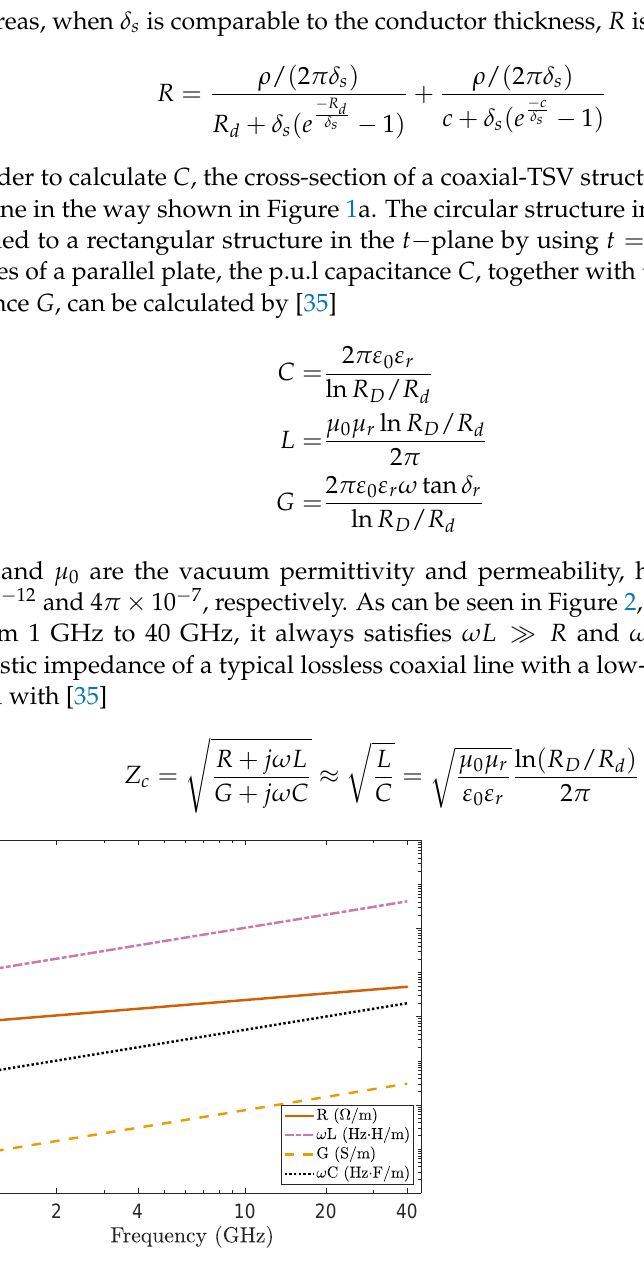
Figure 2. The comparison of R and ω L and the comparison of G and ω C at frequencies from 1 GHz to 40 GHz, when R D , R D , and c are 57µm, 25µm, and 10µm, respectively, and the dielectric is silicon ( ε r = 11.9, tan δ = 0.015, and ρ (cid:62) 100 Ω